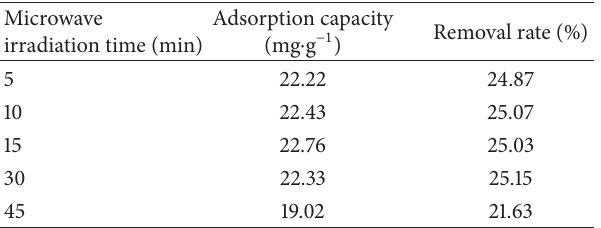
Table 2: Adsorption capacity and removal rate of particle electrodes on MB removal with the effect of microwave irradiation time.